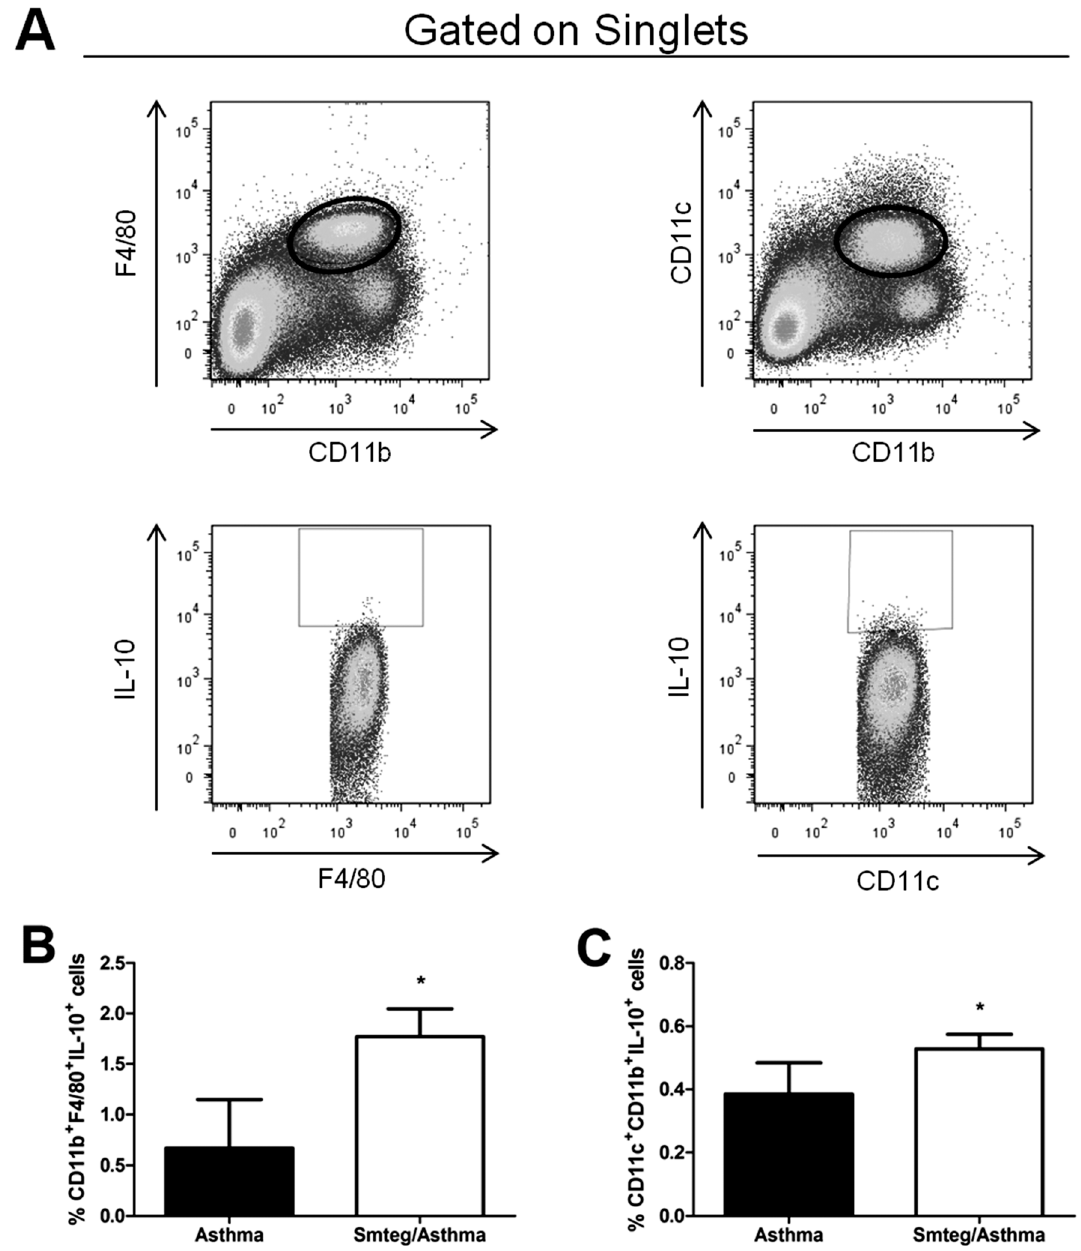
Fig 5. Increased production of IL-10 by monocytes in lungs of Smteg treated mice. Lungs cells were stained as described in Materials and Methods. Analysis strategy was represented in A . Mice of the Smteg/Asthma group presented higher percentage of IL-10 producing cells expressing ( B ) macrophage or ( C ) dendritic cells markers compared to Asthma group. * p < 0,05; Student's t